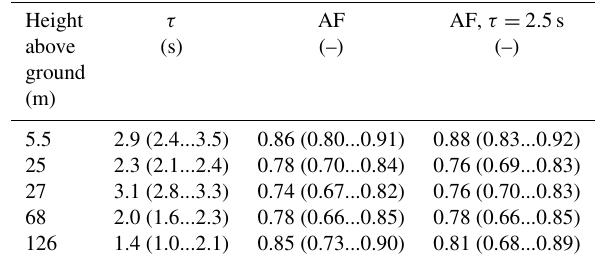
Table 1. Response times ( τ ) describing the high-frequency response of the DTS system derived via comparison with 3D sonic anemome- ters at different heights above ground (see Eq. 5), and attenuation factors (AFs) describing the attenuation of temperature variance due to the high-frequency loss of the signal. A total of 200 estimates for τ were estimated by bootstrap sampling the available data for each height, and the reported values are the medians (interquartile range) of the 200 estimates. AF was estimated for both height-dependent and constant τ for each 30min time period during the measurement campaign with Eq. (6), and the reported values are the medians (in- terquartile range) of the AF time